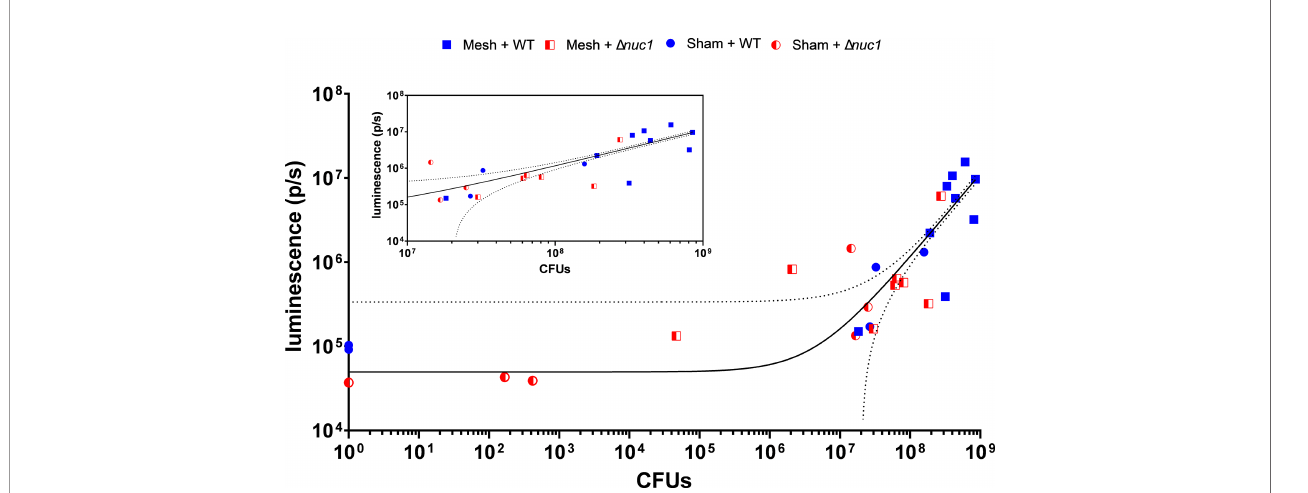
FIGURE 5 | Bacterial bioluminescence as a function of CFU counts of all mice involved in the experiment that were inoculated with either S. aureus Newman WT lux or S. aureus Newman D nuc1 lux. At the inset the same data is shown with an adjusted (cropped) X-axis for more clear inspection of the individual datapoints at the higher end of the X-axis. The black line fl anked by dotted line represents a linear correlation with 95% CI, R-squared=0.9395. The lower threshold of the 95% CI intersects the X-axis at a total of 2.1*10 7 CFUs, indicating the lowest number of bacteria theoretically detectable with using this linear correlation.